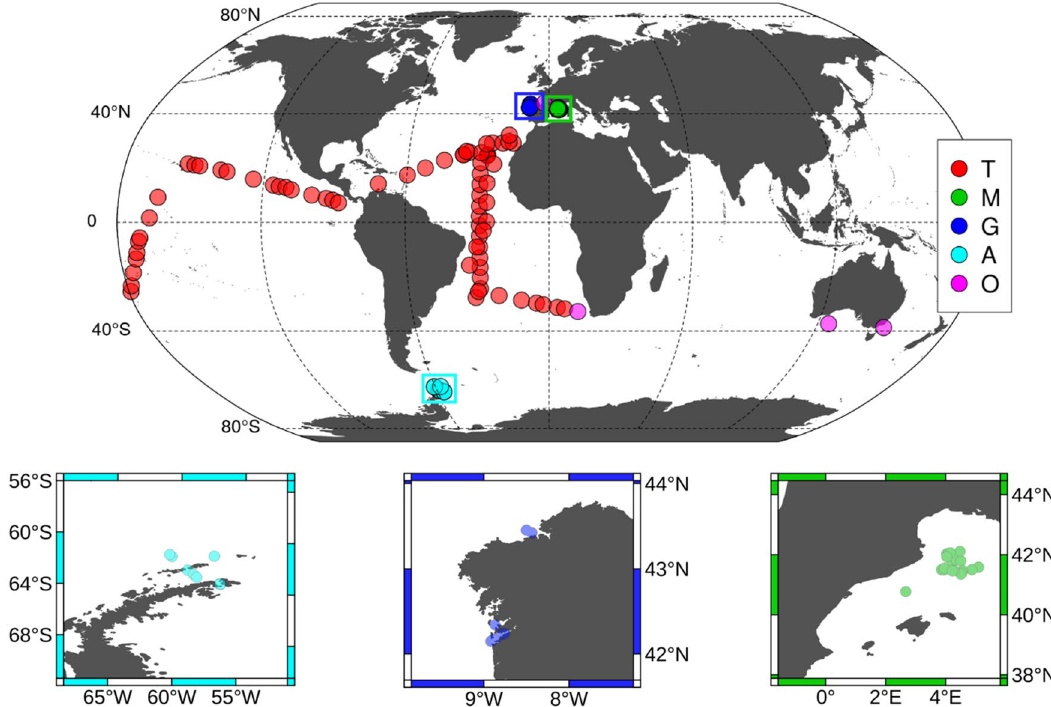
Figure 1. Location of the stations used in this study. Stations sampled in tropical and subtropical regions (T) are shown in red, the Mediterranean Sea (M) in green, the Galician coastal upwelling (G) in dark blue, the Antarctic Peninsula (A) in light blue and other regions (O) in pink. Small panels provide details about those stations sampled in the Antarctic Peninsula (light blue), the Galician coastal upwelling (dark blue) and the Mediterranean Sea (green). Figure was generated by using Matlab R2018b (https:// es. mathw orks.